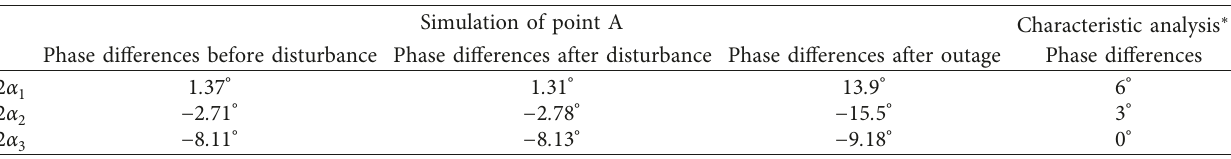
, η . 75 , η . 5. 1 (cid:31) η 2 (cid:31) 1 3 (cid:31) 0 4 (cid:31) 0